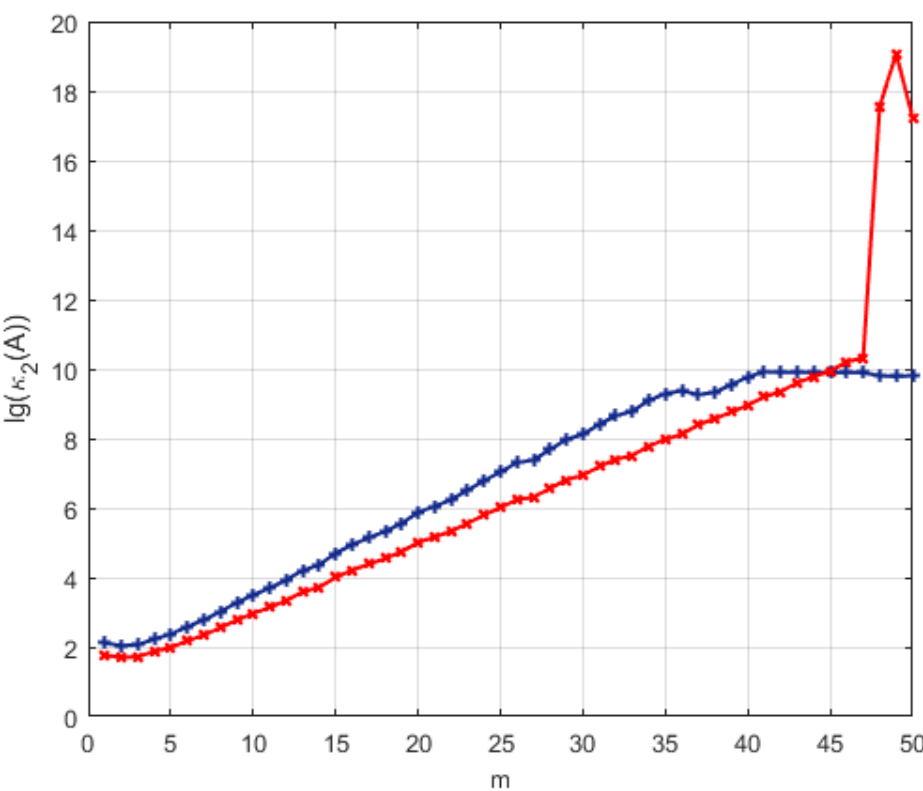
(cid:16) (cid:16) (cid:17)(cid:17) κ 2 (red line) and lg ( κ 2 ( A ( k ))) (blue (cid:101) A